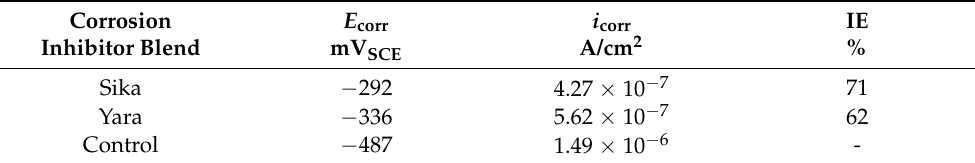
Table 5. CPP parameters obtained for steel rebars exposed to commercial corrosion inhibitor blends (Sika and Yara) in SCPS with 0.6 NaCl.